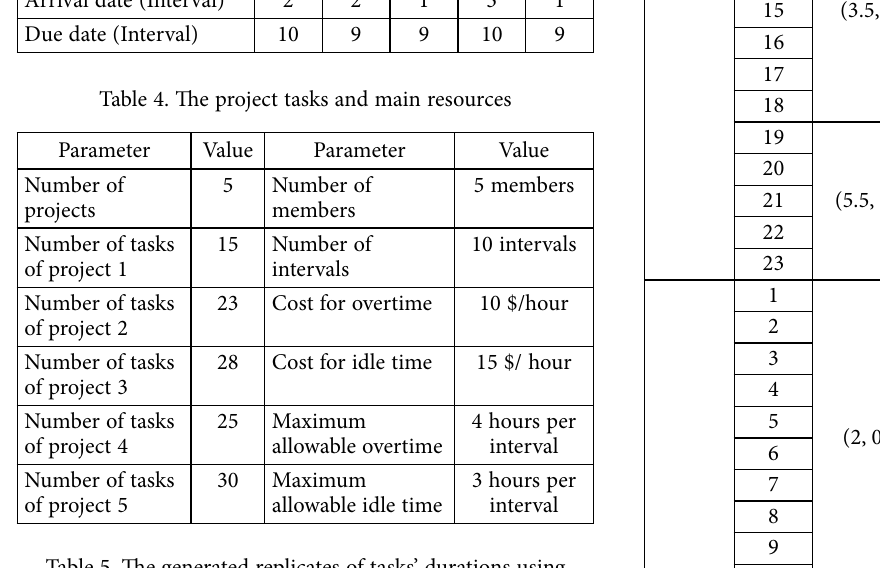
Table 5. The generated replicates of tasks’ durations using normal